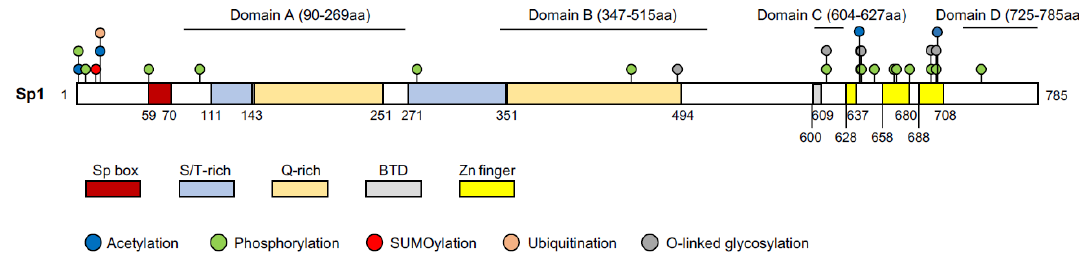
Figure 2. Protein structure of Sp1 with indicated domains and post-translational modifications. Domains A, B, C, and D indicate transactivation domains. All of the other domains are indicated in boxes with different colors. Putative post-translational modifications are labelled in color-coded circles. The numbers under the protein indicate the position of the amino acid at the border of the domains. S/T-rich: serine/threonine-rich domain; Q-Rich: glutamine-rich domain; BTD: Buttonhead domain; Zn finger: Cys2His2-type zinc finger domain. UniProt ID: P08047 and references [46–48].